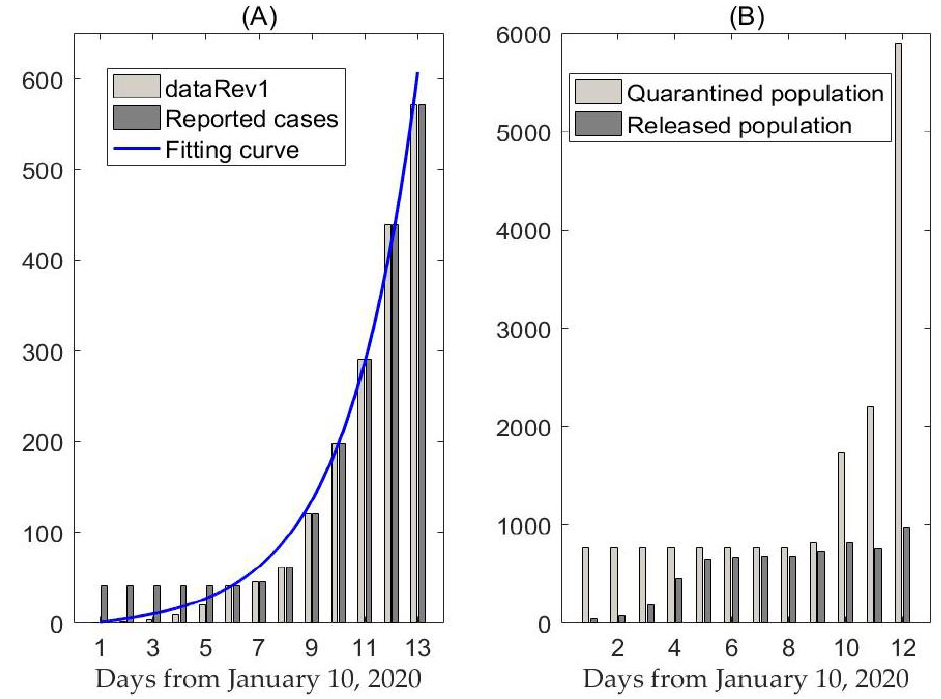
Figure 1. ( A ) Cumulative diagnoses and revised case data (dataRev1) in mainland China, the blue curve is the best fitting curve of model (1) to dataRev1. ( B ) Data information of cumulative quarantined/released population.